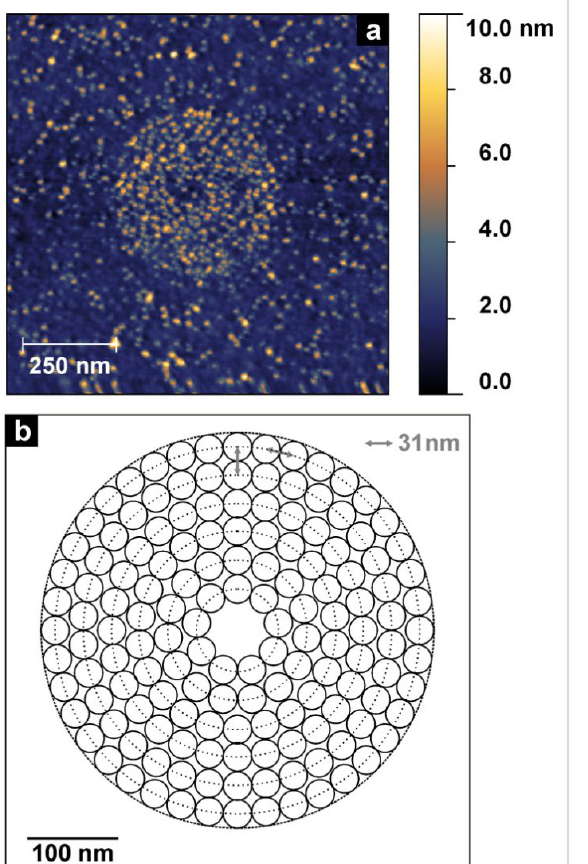
Figure 5: Super structure of immobilised 6 nm AuNPs on a circular structure written by CEBL (a) and possible grating pattern of a circle to be written with a beam step size of 31 nm (b).